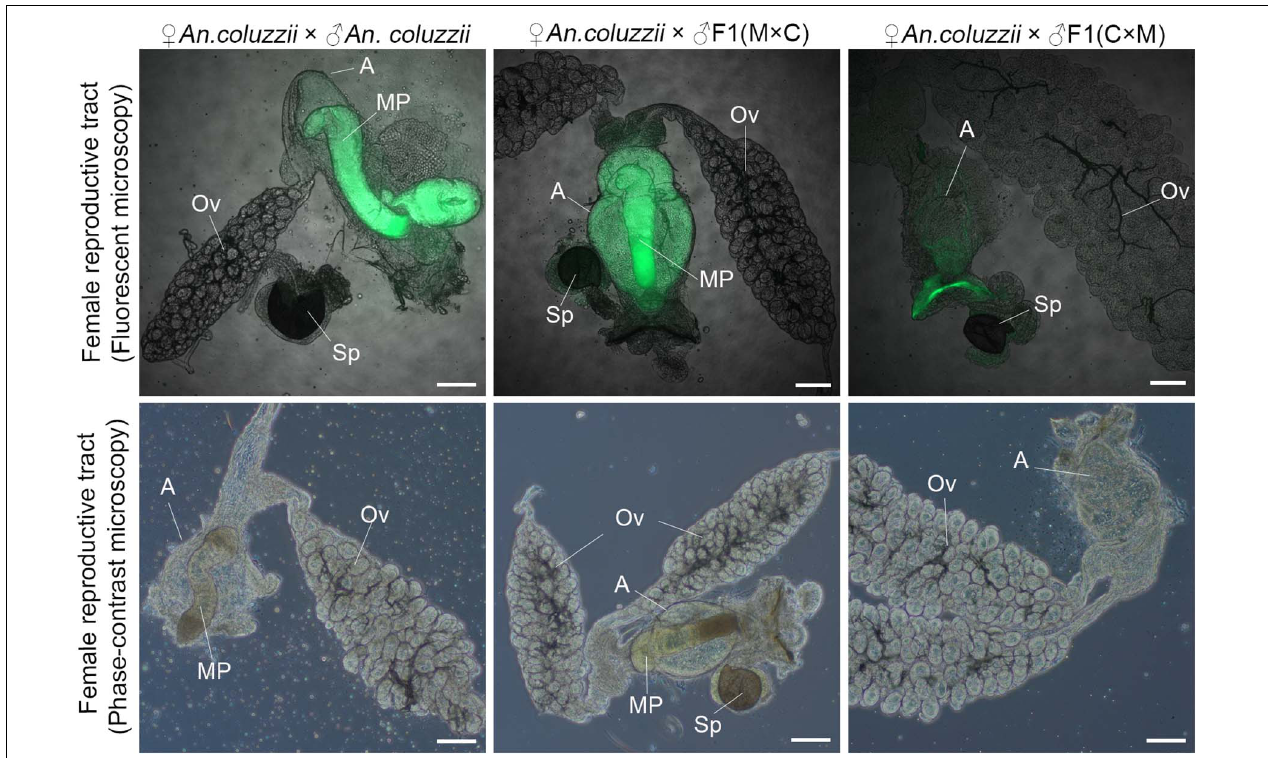
FIGURE 7 | Analysis of the mating plug transfer to the atrium of An. coluzzii females. The presence or absence of the mating plug in the atria are shown for females mated with an An. coluzzii male and with hybrid males from the reciprocal inter-species crosses. MAG-derived lipids autofluoresce in green color. ED, ejaculatory duct; T, testis; Ov, ovary; A, atrium; MP, mating plug; Sp, spermatheca; M × C, Scale bar = 100 µ m.